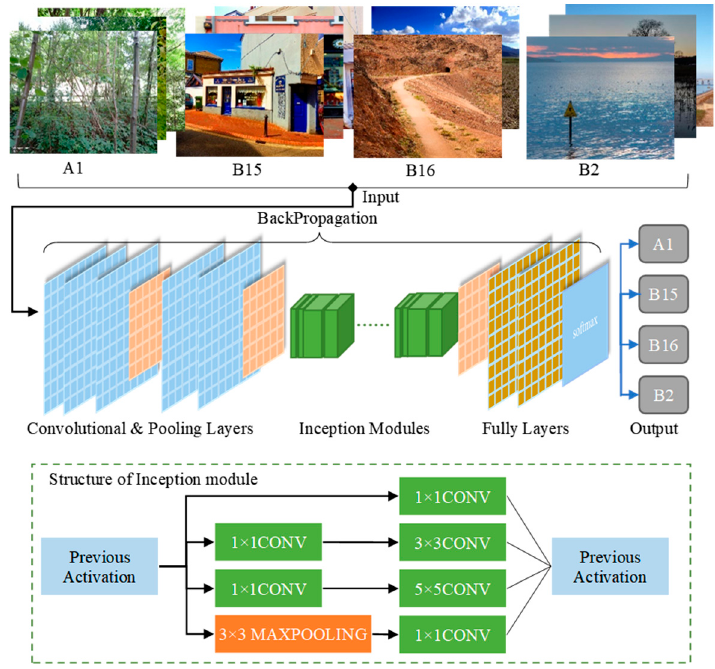
Figure 5. Structure of NSIC-Inception model based on transfer learning.